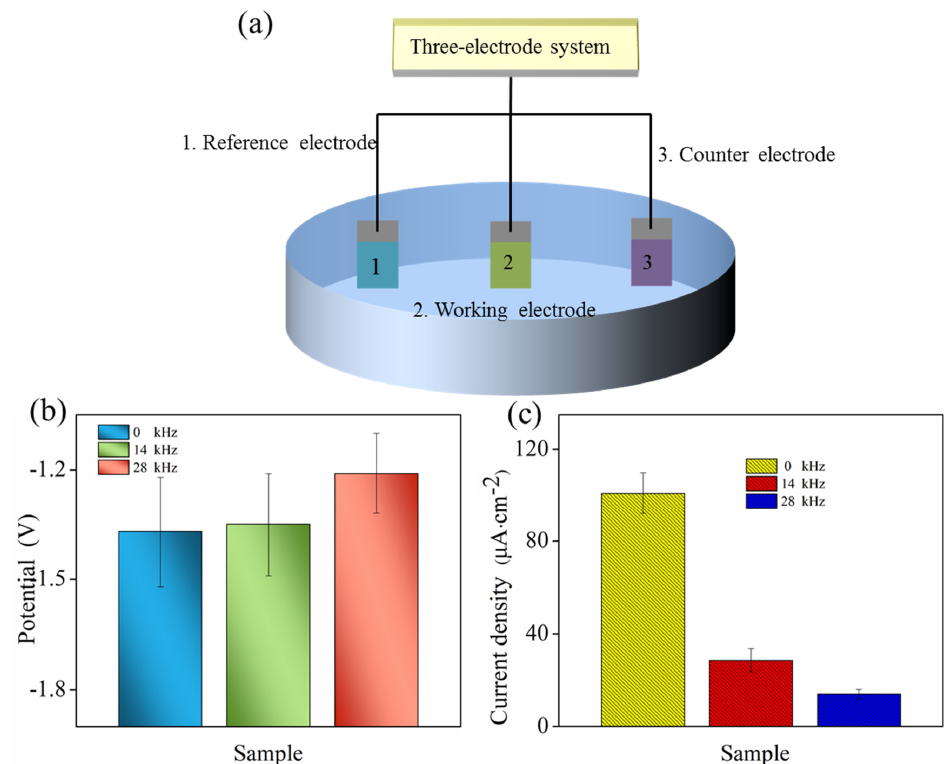
Figure 5. Electrochemical corrosion characteristics of U-treatment Mg alloy with F-treatment Mg alloy as the control group: ( a ) explanation of the measurement method; ( b ) corrosion potential and ( c ) corrosion current density.